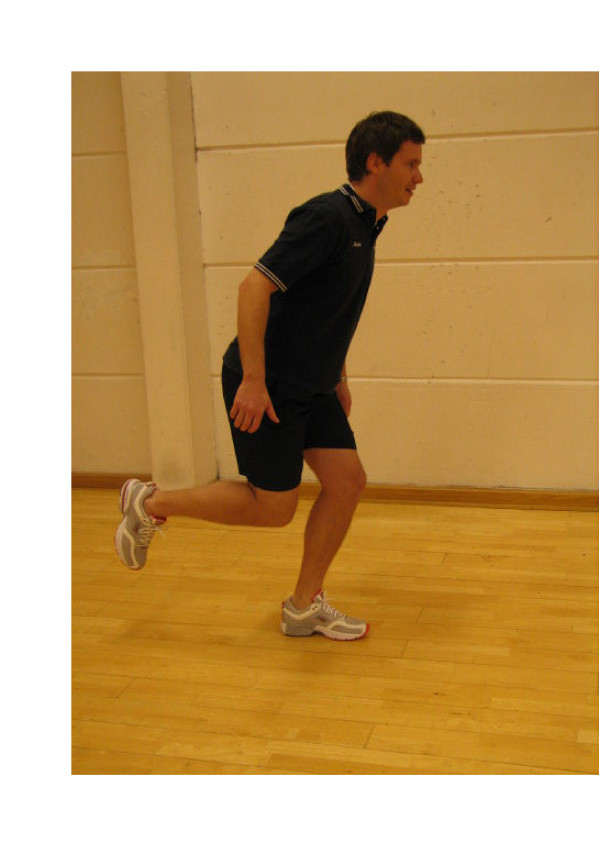
Jumping on one leg with knee control and knee elasticity during landing.